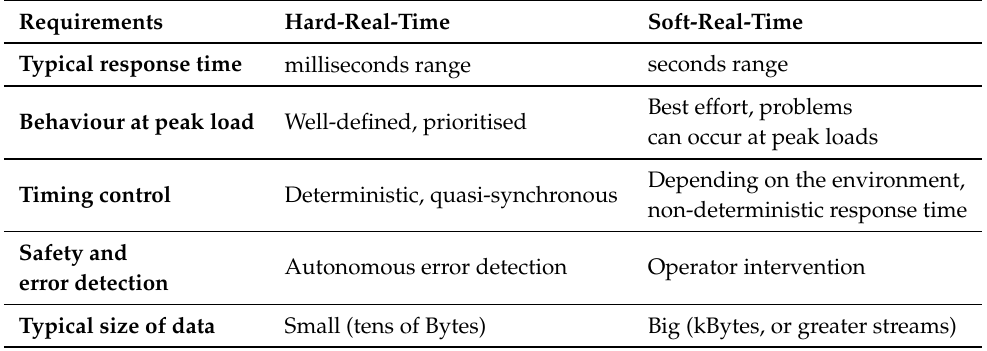
Table 1. Requirements for messages of hard-real time and soft-real time data transfer within SciL.